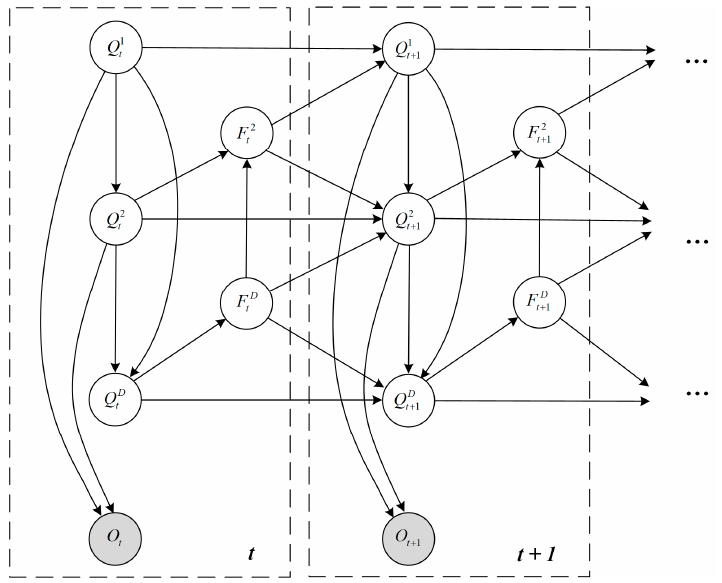
Figure 10. The equivalent dynamic Bayesian network (DBN) representation of the proposed two-level hierarchical HSMM, unrolled for two time slices. The semantics of a DBN is defined by unrolling the two-time-slice Bayesian network (2TBN) until we have T time slices, where T denotes the length of the time series.